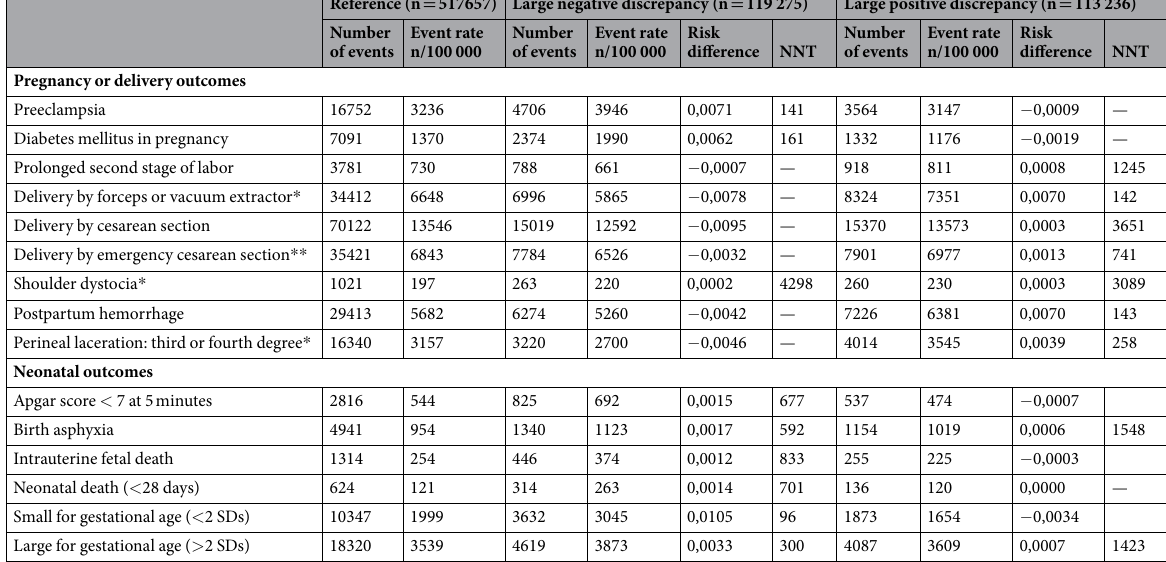
Table 2. Number of events, risk difference, and numbers needed to treat (NNT) for adverse obstetric and neonatal outcomes according to discrepancy between pregnancy dating methods. Number of events, risk difference, and numbers needed to treat (NNT = 1/risk difference) for adverse obstetric and neonatal outcomes among all recorded singleton births in Sweden 1995–2010, with documentation of the date of last menstrual period, US-based estimated date of delivery, maternal weight, and height according to the discrepancy between pregnancy dating methods. Negative discrepancy indicates that the EDD by LMP was at an earlier date than was the EDD by US. Positive discrepancy indicates that the EDD by LMP was at a later date. A large negative discrepancy was defined as below the 10 th percentile, and a large positive discrepancy as above the 90